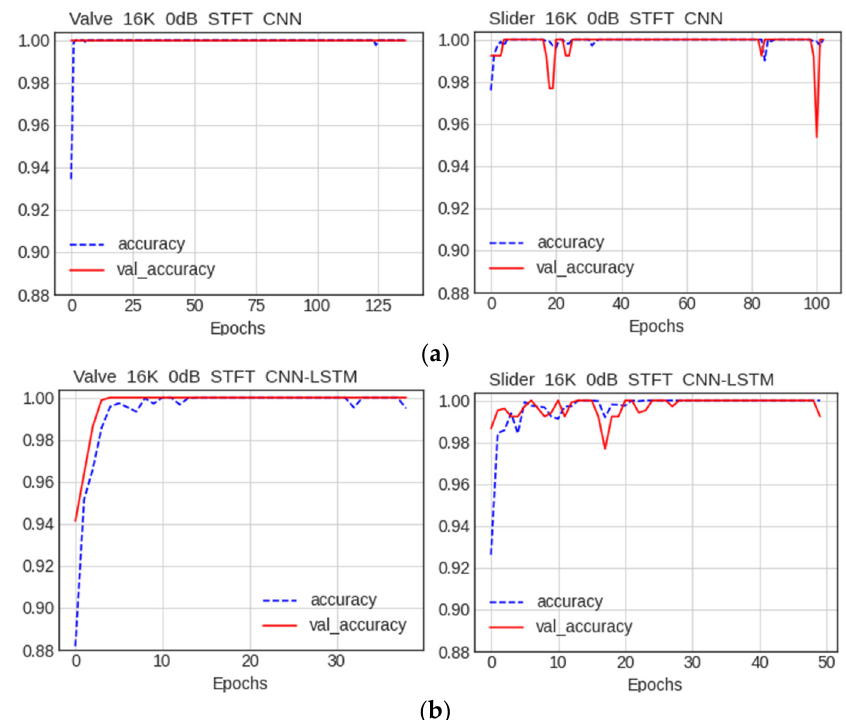
Figure 15. Accuracy of using the STFT data consisting of valves, and slide rail data (16 K): ( a ) results of training on the CNN model; and ( b ) results of training on the CNN–LSTM model.